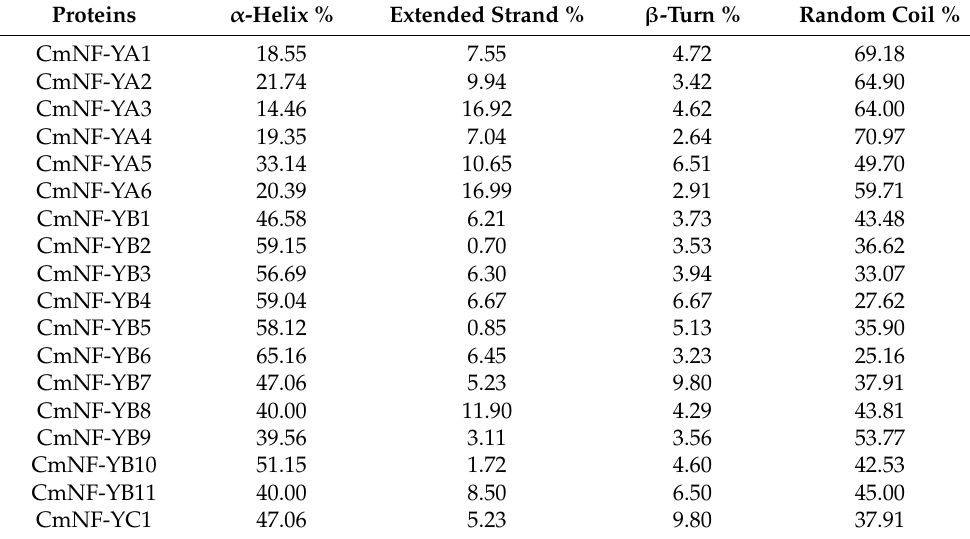
Table 2. Secondary structure of CmNF-Ys